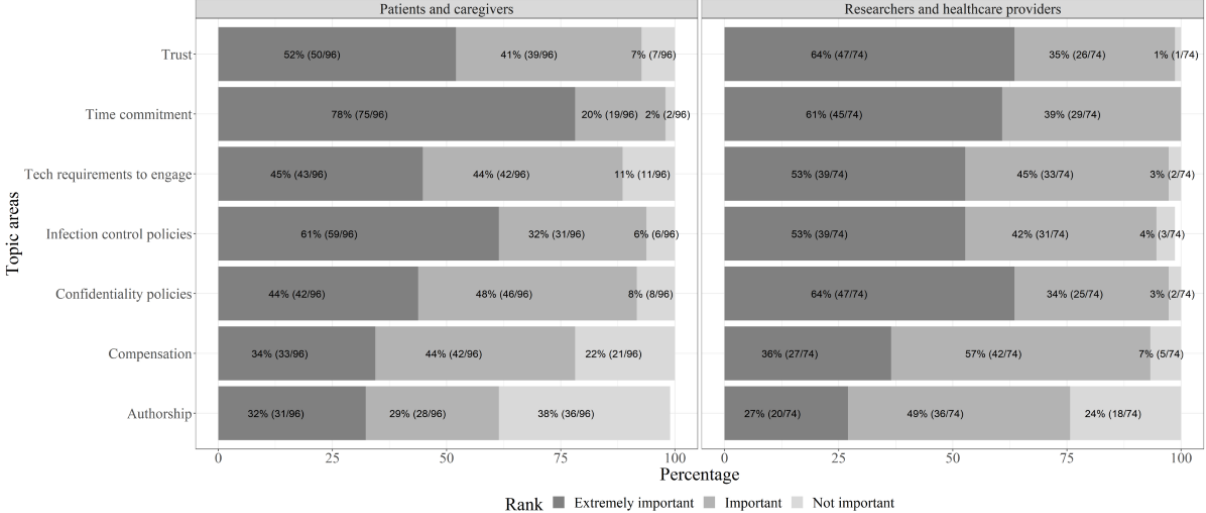
Figure 1. Desired topics to address in patient-centered outcomes research (PCOR) training by participant